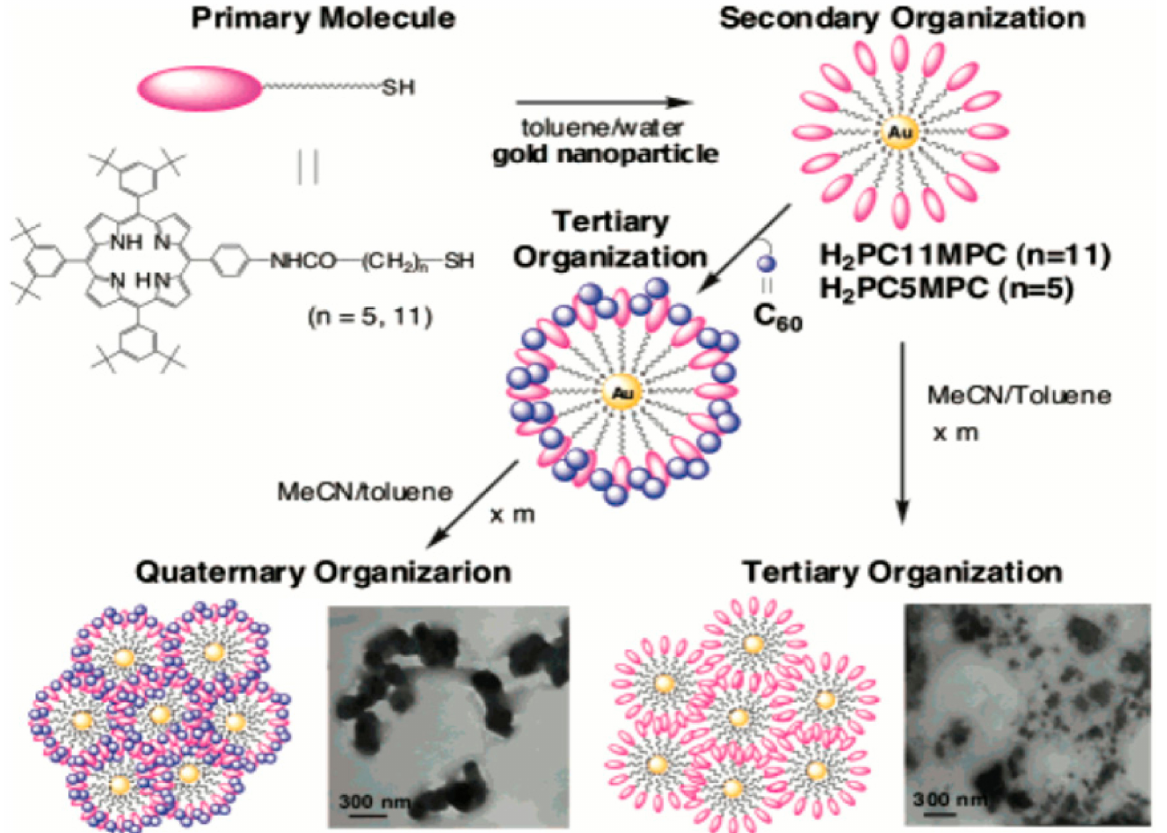
Figure 3. Nanocomposites based on porphyrin interaction and C60 on Au NP surface. ACS, 2003, reproduced with reference permission [44].